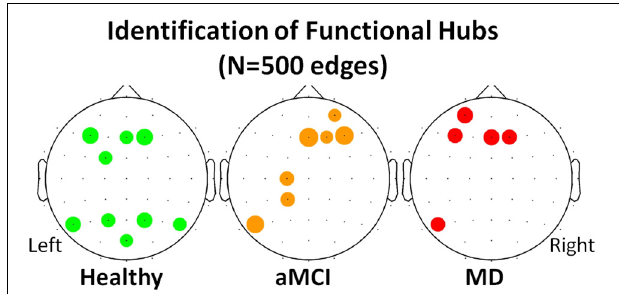
FIGURE 5 | Visualization of the functional hubs identified for each one of the three groups (Healthy, aMCI and MD). The hub identification was based on the normalized relative betweenness centrality value. According to a previous study, a node is defined as a hub when its centrality value is greater or equal to 1.5 (Seo et al., 2013). This threshold is a strict one. Therefore, the analysis was performed on the lower density range ( N = 500). A small density value is more likely to result in a greater number of functional hubs. The hubs (names and locations) are visualized in a sensor level for each group. The hub strength is also reported through its relative betweenness centrality (b i ) value.